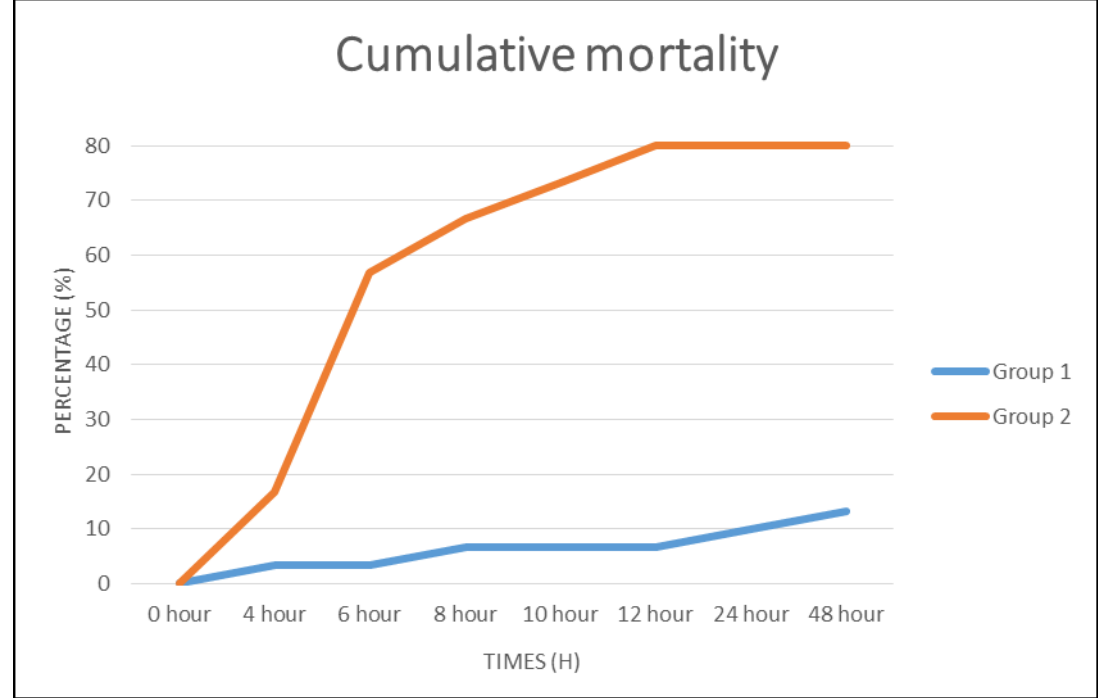
Figure 4. The cumulative mortality of marine red hybrid tilapia post-challenge with 10 8 CFU/mL of live virulent Vibrio harveyi by intraperitoneal injection. Group 1 = vaccinated; Group 2 = non vaccinated.